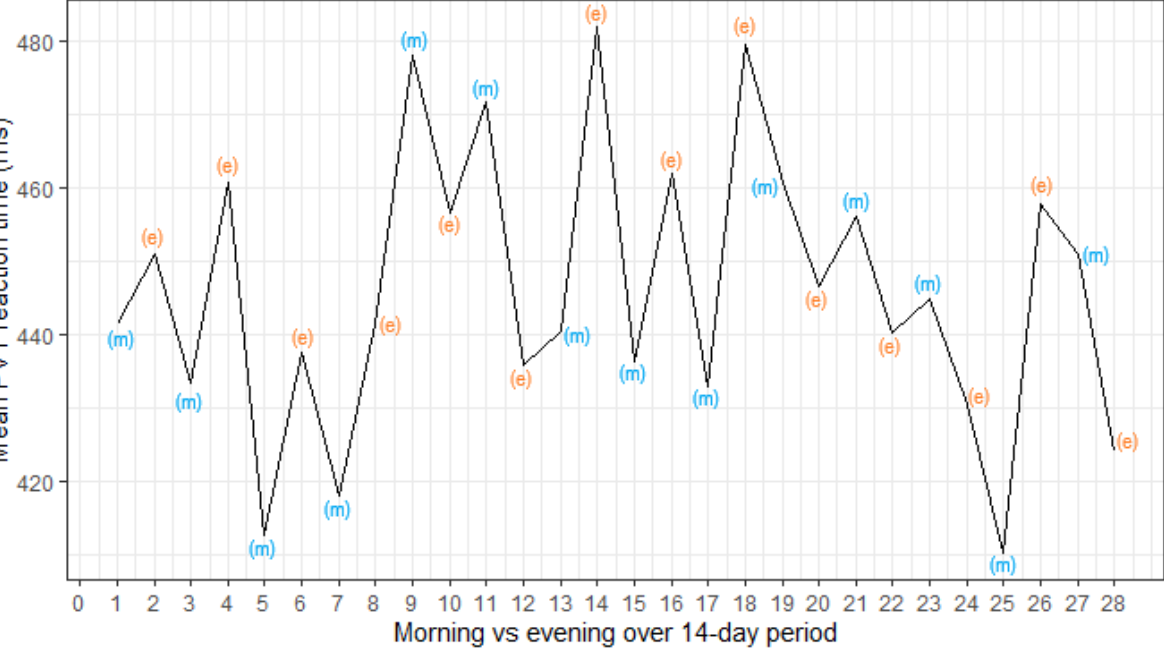
Figure 5. Mean psychomotor vigilance task reaction time (across all participants) as a function of the time of day (morning vs evening) and study day (day 1 to day 14). PVT: psychomotor vigilance